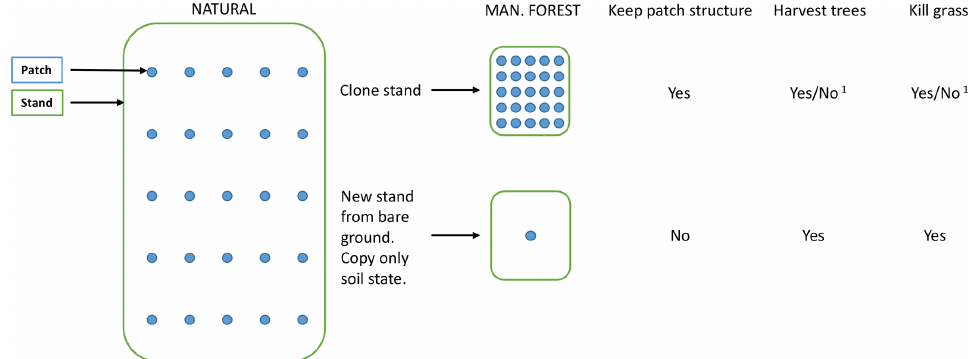
Figure B1. Options when creating managed forest stands from PNV. 1 For the cloning alternative, tree harvesting and grass killing are optional.